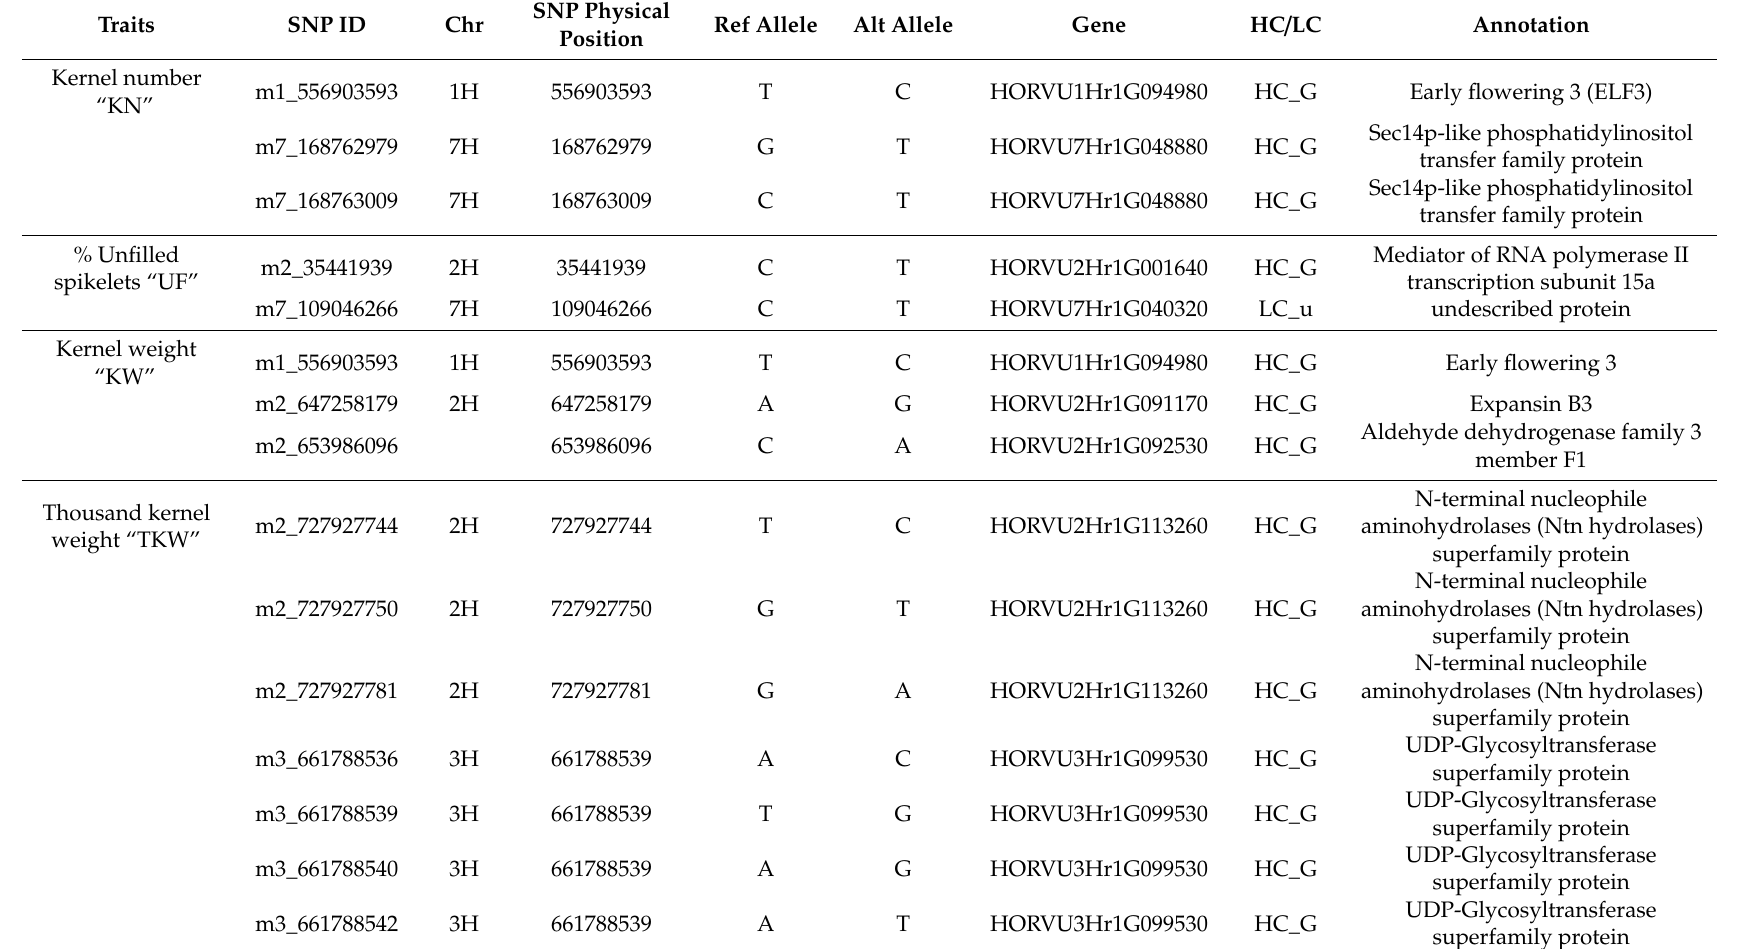
Table 1. Significant single-nucleotide polymorphisms (SNPs) showing the highest marker-trait associations for the central spikelet.